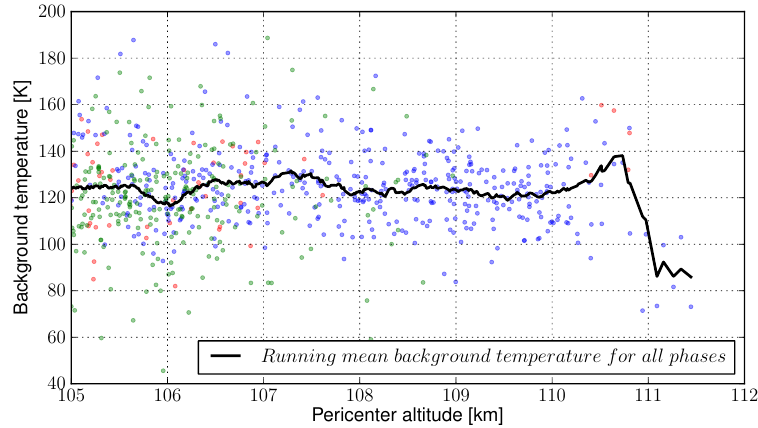
Figure 11. The derived mean temperature as the function of the pericenter altitude for all passes. Dots represent individual orbits, and the solid line is the running average within the